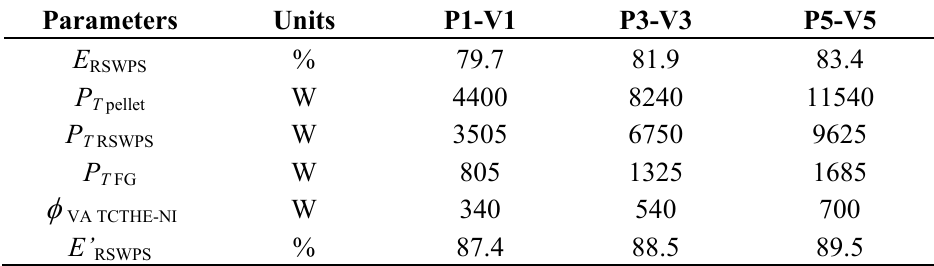
Table 9. Values of the RSWPS efficiency including heat recovered by the TCTHE-NI. Parameters